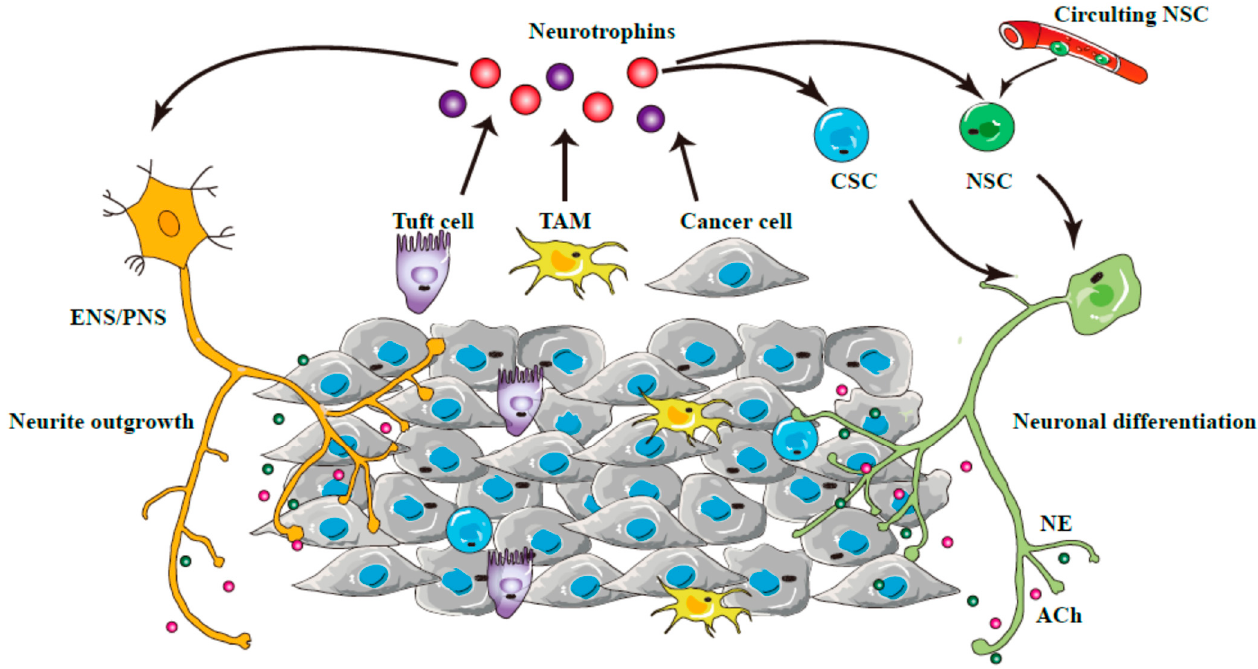
Figure 2. The mechanisms underlying neurogenesis during GI cancer development. The release of neurotrophins from various cell types, including tumor-associated macrophages (TAMs), tuft and cancer cells, may lead to neurite outgrowth of ENS/PNS and the differentiation of cancer stem cells (CSCs) and circulating neural stem cells (NSCs) into neurons, to fuel GI tumorigenesis. NE, Norepinephrine; ACh, acetylcholine.